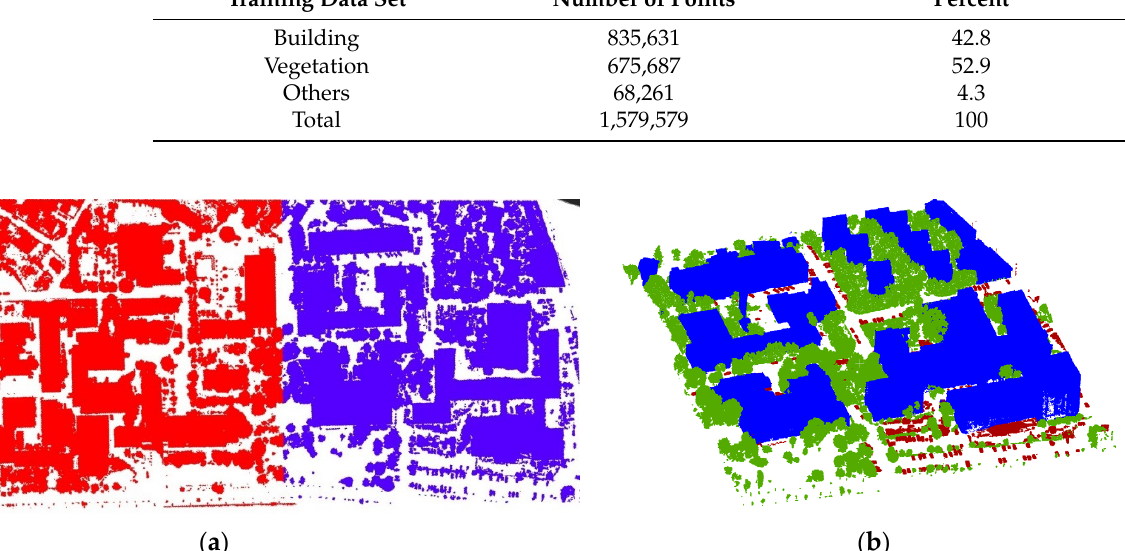
Figure 20. Classification model ‐ detail of decision trees The overall accuracy of the classifier is 92%, with an overall miss ‐ classification rate of 8%. The confusion matrix is presented in Table 5.